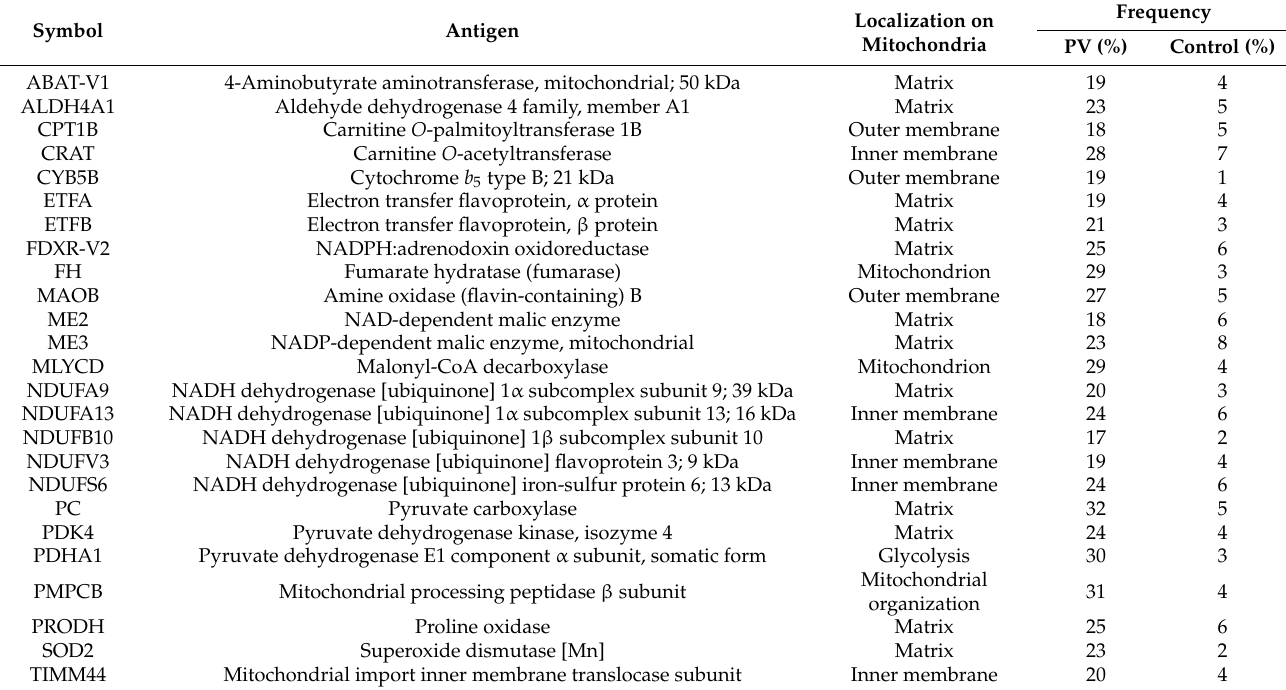
Table 1. Mitochondrial autoantibodies in patients with PV (adapted from Kalantari et al. [18])